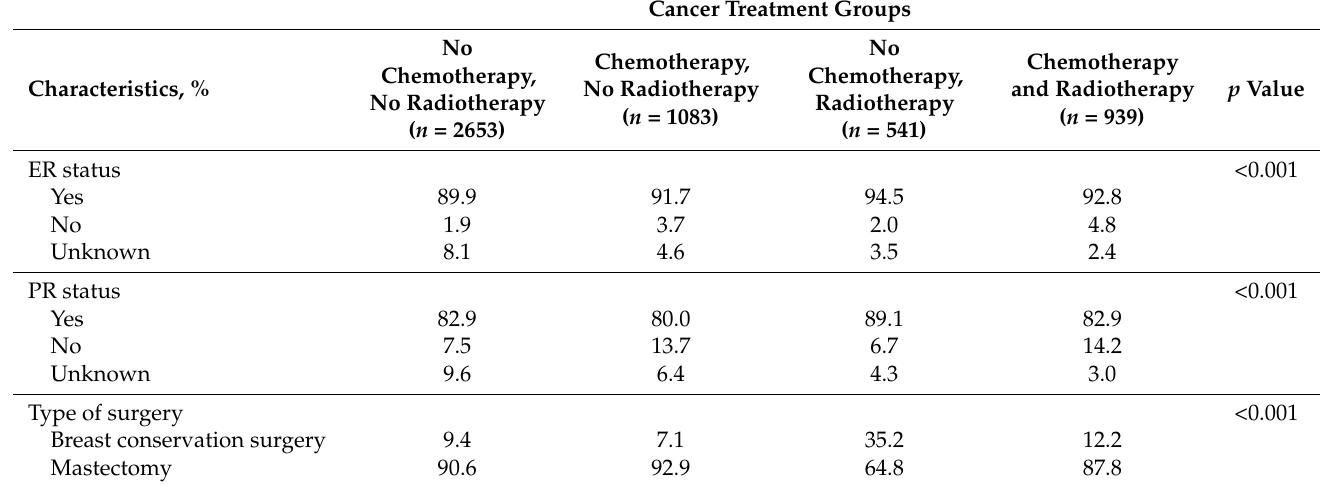
Cancer Treatment Groups